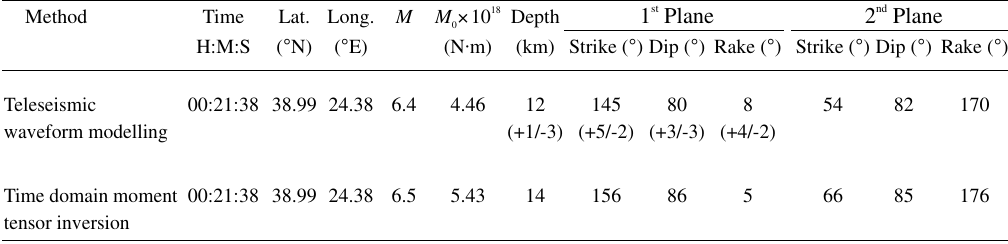
Table I. Source parameters of the July 26, 2001 Skyros earthquake derived from the two applied methodologies. In the case of the teleseismic waveform modelling, the numbers in the brackets indicate the lower and upper bounds of the uncertainties.